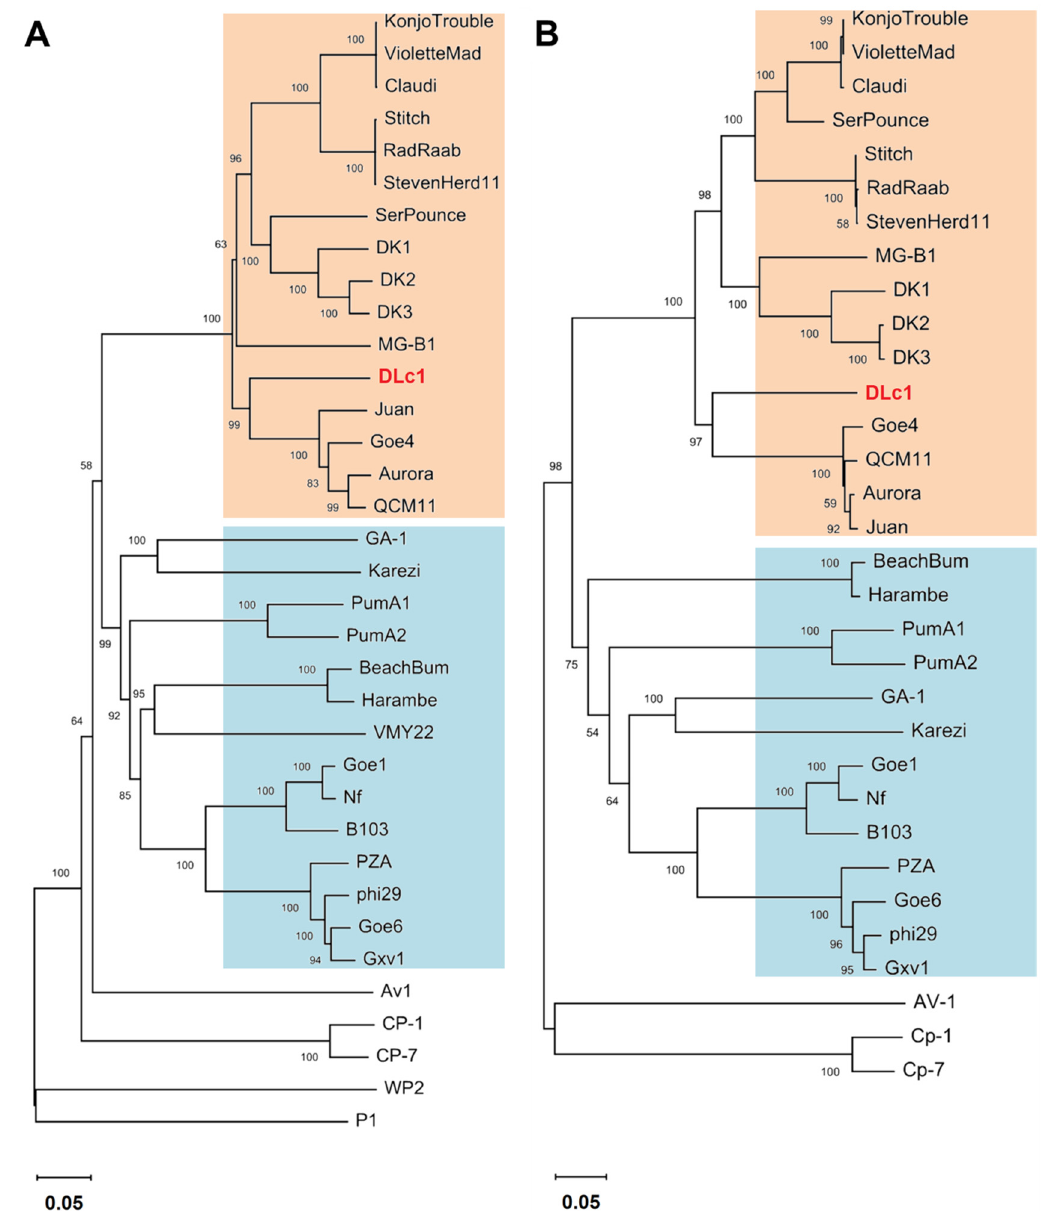
Figure 5. Phylogenetic classification of the ϕ 29-like phages and other members sorted in the current Picovirinae subfamily. The genes encoding DNA polymerase ( A ) and terminal protein ( B ) are set as markers to construct the phylogenetic tree, respectively. Two clusters are colored in orange or blue background, respectively.